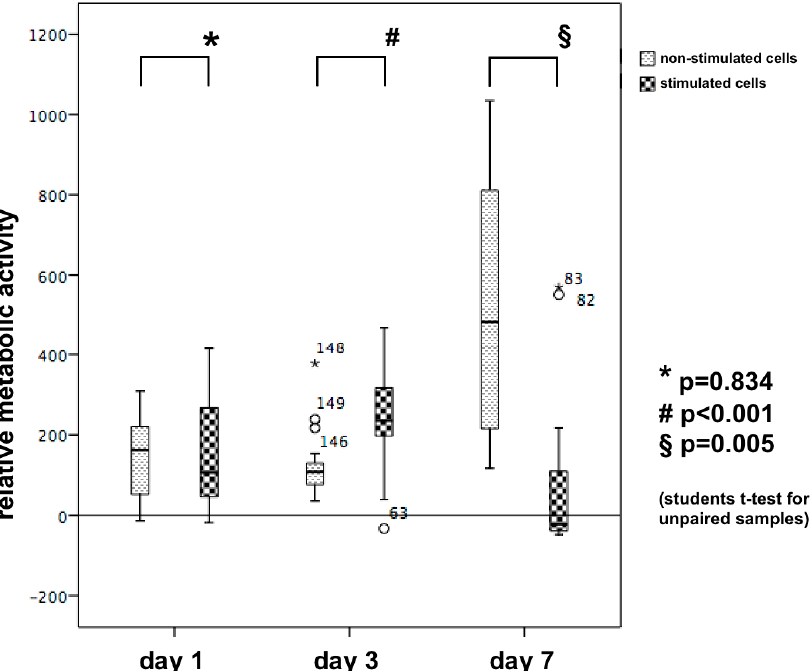
Figure 7. Boxplots for illustration of the proliferation/relative metabolic activity in stimulated and non-stimulated cell samples after 24 h, 3 and 7 days of continuous electrical stimulation. At day 3, the proliferation was doubled in the stimulated cells and in contrast, at day 7 this was doubled in the controls while the stimulated cells reduced their proliferation